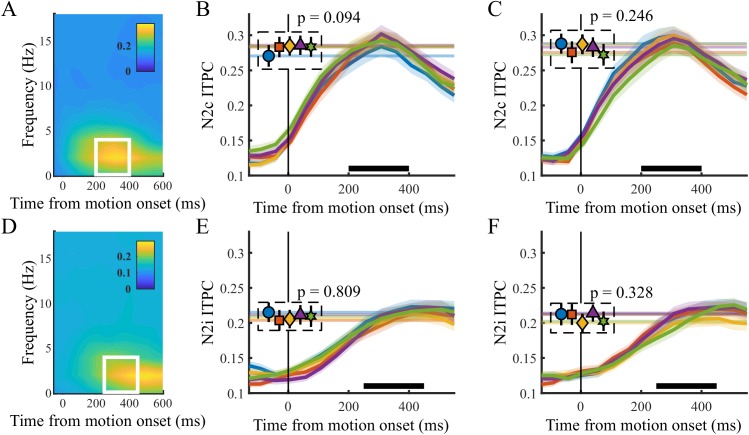
N2 ITPC.(A) Grand average inter-trial phase coherence (ITPC) per time-frequency point for the N2c. White box represents the time-frequency window selected for statistical analyses. (B) N2c ITPC per pupil response bin, (C) N2c ITPC per baseline pupil bin. Horizontal lines and markers indicate average ITPC per pupil bin during the time window indicated by the black bar. (D–F) As in A-C but for N2i. Note that the time window used for the N2i analysis did not cover the peak ITPC activity, but rather focused on the time window in which the N2i amplitude peaked (Figure 3D). Error bars and shaded regions denote ± 1 SEM. Stats, linear mixed effects model analyses (Statistical analyses).